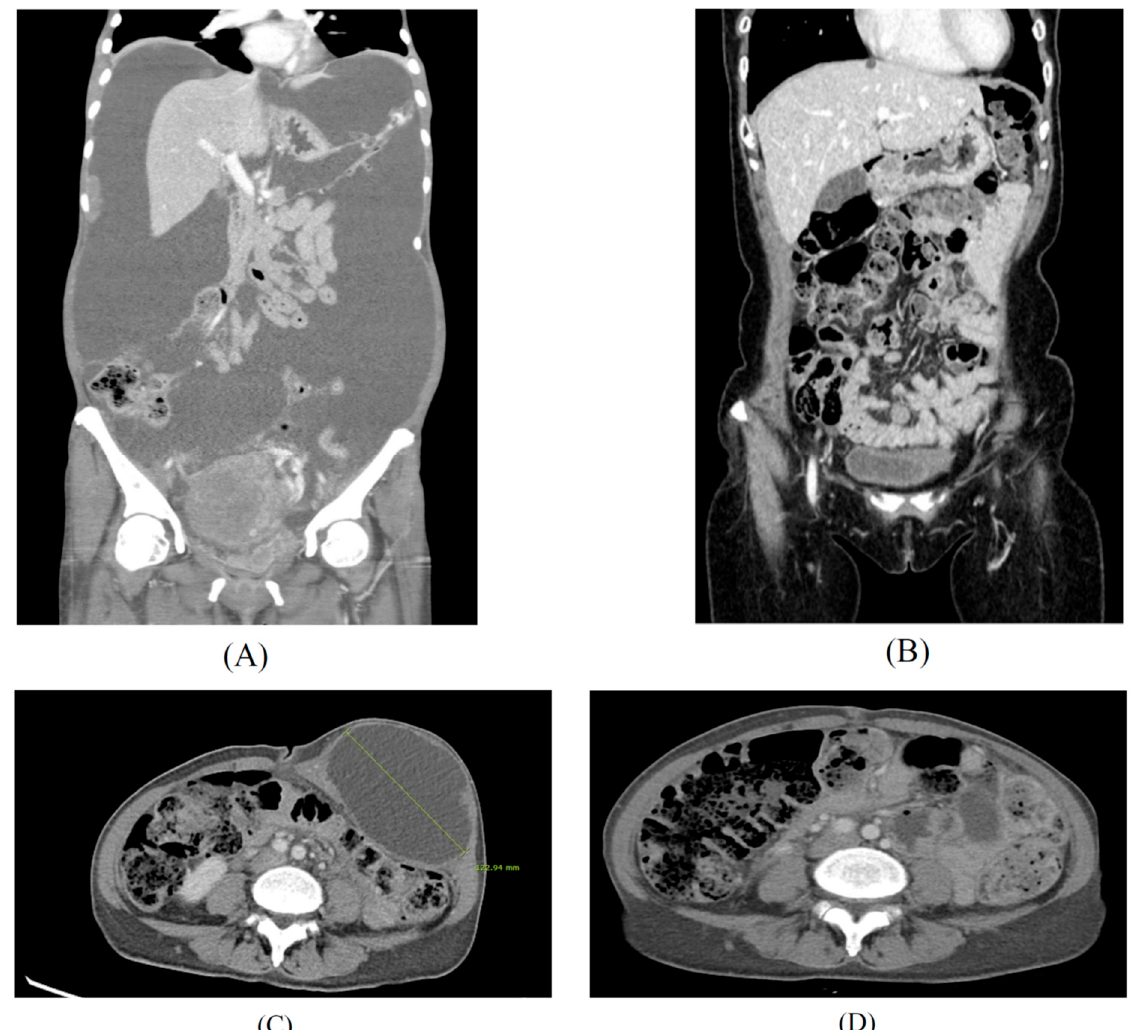
Figure 4. High doses of sodium selenite in treatment of advanced metastasis cancer patients. Case 1: Findings of abdomino-pelvic CT before ( A ) and after ( B ) the multidisciplinary treatment for a 51-year-old patient diagnosed with advanced stage ovarian cancer. Case 2: Findings of abdomino-pelvic CT before ( C ) and after ( D ) the integrative treatment for a 48-year-old patient diagnosed with recurrent ovarian cancer after primary intensive pelvic surgery with adjuvant chemotherapy, since 2017. Peritoneal carcinomatosis with massive ascites ( A ) and no evidence of disease ( B ) after 18 months of chemotherapy, interval debulking surgery, and PARP inhibitor maintenance therapy with high dose sodium selenite treatment according to regimen of Table 1 (SIMCH). Metastatic para-aortic lymph nodes with 12 cm-sized port site metastatic mass at left lower abdominal wall was noted ( C ), and no evidence of disease at left lower abdomen and stable disease of metastatic lymph nodes ( D ) after 16 months of metastatectomy of abdominal wall and maintenance immune checkpoint inhibitor (pembrolizumab) with high dose sodium selenite treatment according to regimen of Table 1 (SIMCH). Table 1. Sodium selenite as integrative medical application to cancer patients at SIMCH.